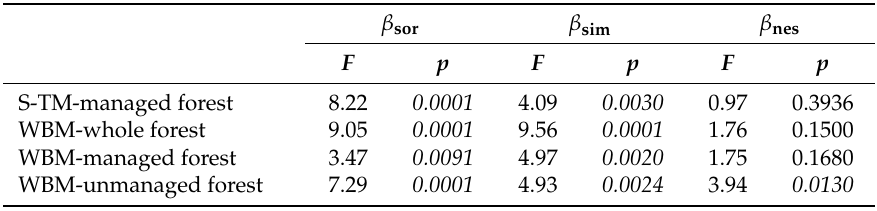
Table 3. The significance of directional herb layer vegetation shifts between the pairs of sampling plots in the 1950s/1970s and 2000s in the Sanocko-Turczanskie Mountains and the Western Bieszczady Mountains. S-TM-managed forest: n = 66; WBM-whole forest: n = 62; WBM-managed forest: n = 30; WBM-unmanaged forest: n = 32 (PERMANOVA test). β sor β sim β nes F p F p F p S-TM-managed